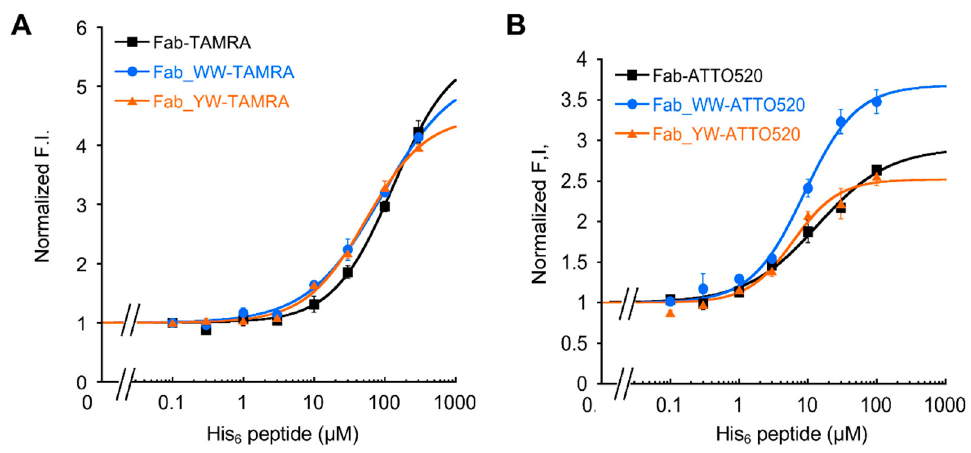
Figure 4. His 6 peptide dose-response of the wild-type and mutant Fab Q-bodies. His 6 dose-response curves of 5-TAMRA C6- ( A ) or ATTO520-C2 ( B ) labeled Fab-type Q-body in PBST. Error bars indicate ±1 SD (n = 3).